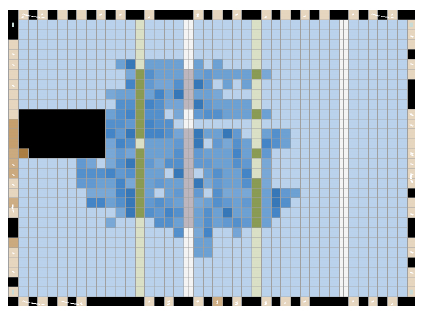
Figure 20. Hardware resources planner of FPGA.